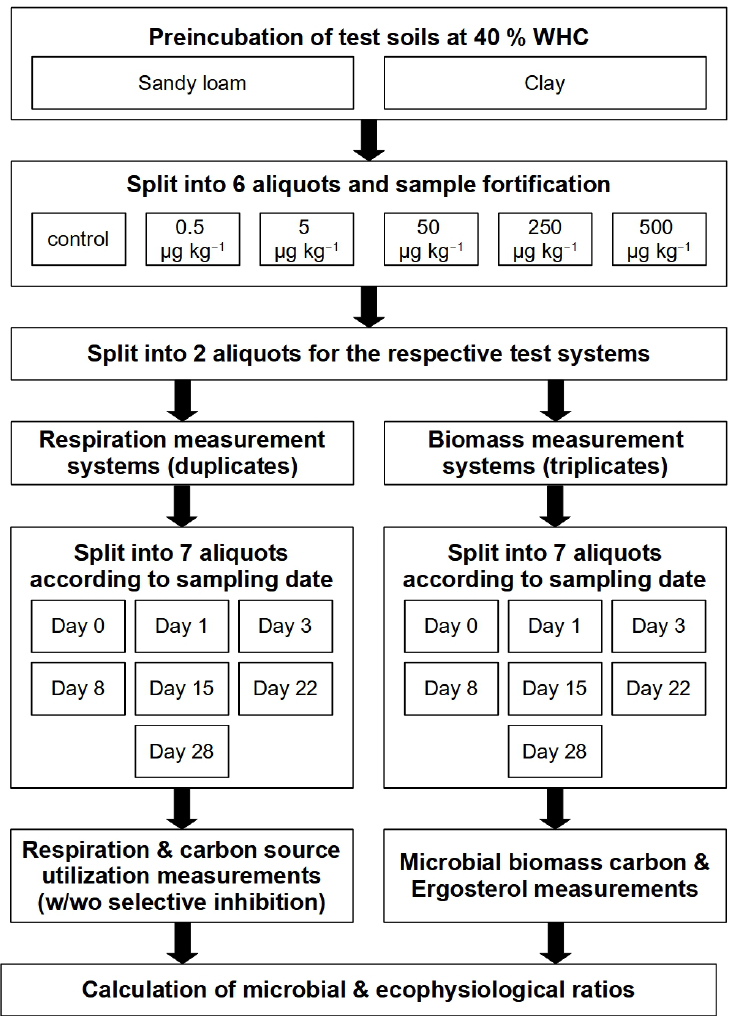
Figure 1. Flowchart describing the study design and experimental set